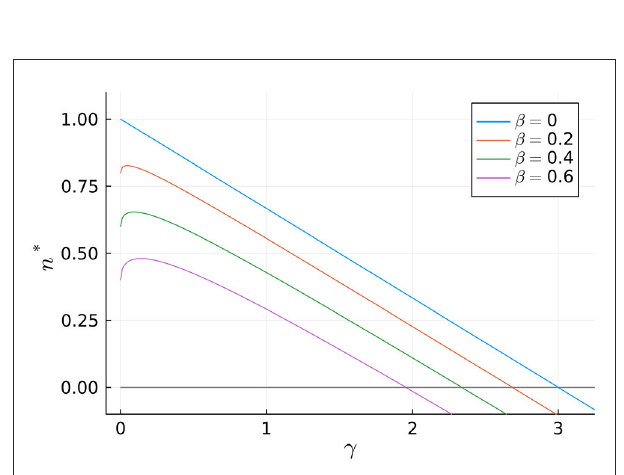
FIGURE2 Dependence of the normalized total mitochondrial volume density, n ∗ , on the normalized fusion rate, γ , for different values of the normalized aging rate, β .